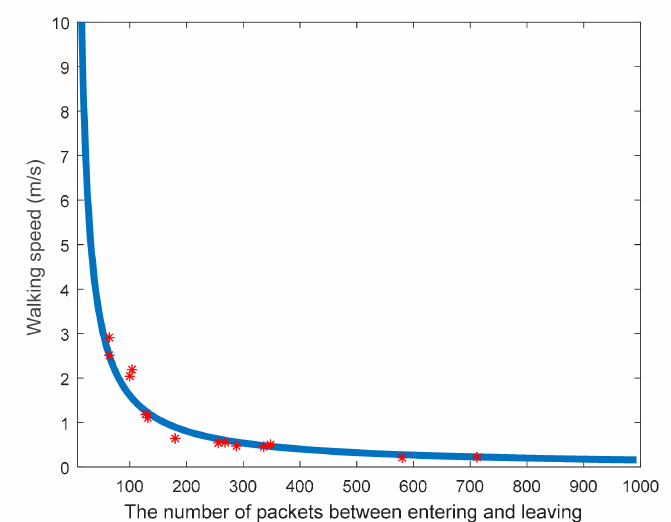
Figure 7. The curve-fitting relationship of velocity versus the number of data packets